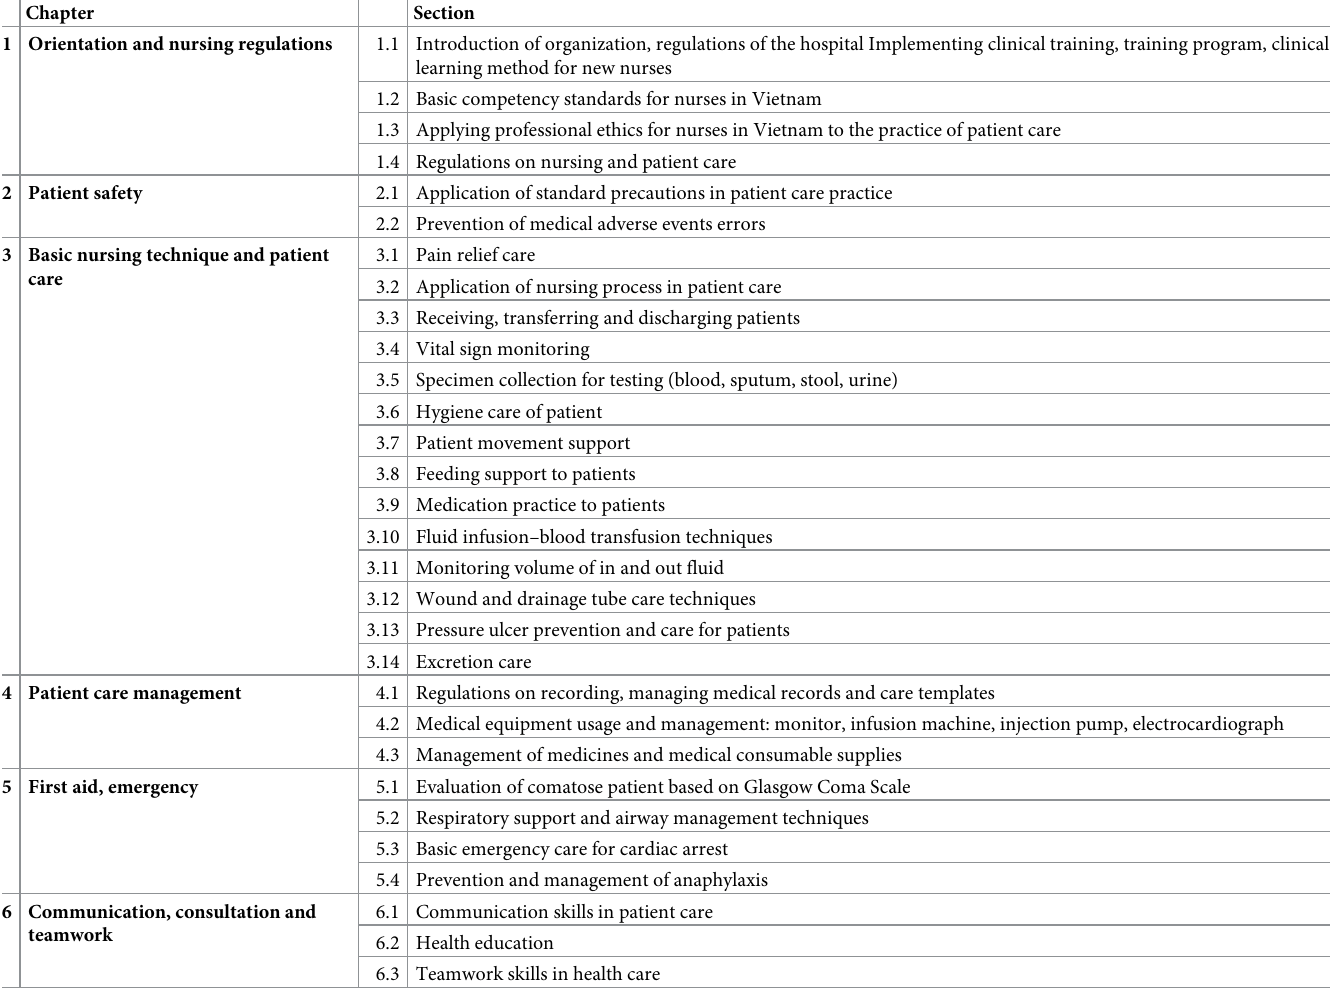
Table 2. Structure and contents of textbook to be used for OJT and Off-JT. Chapter